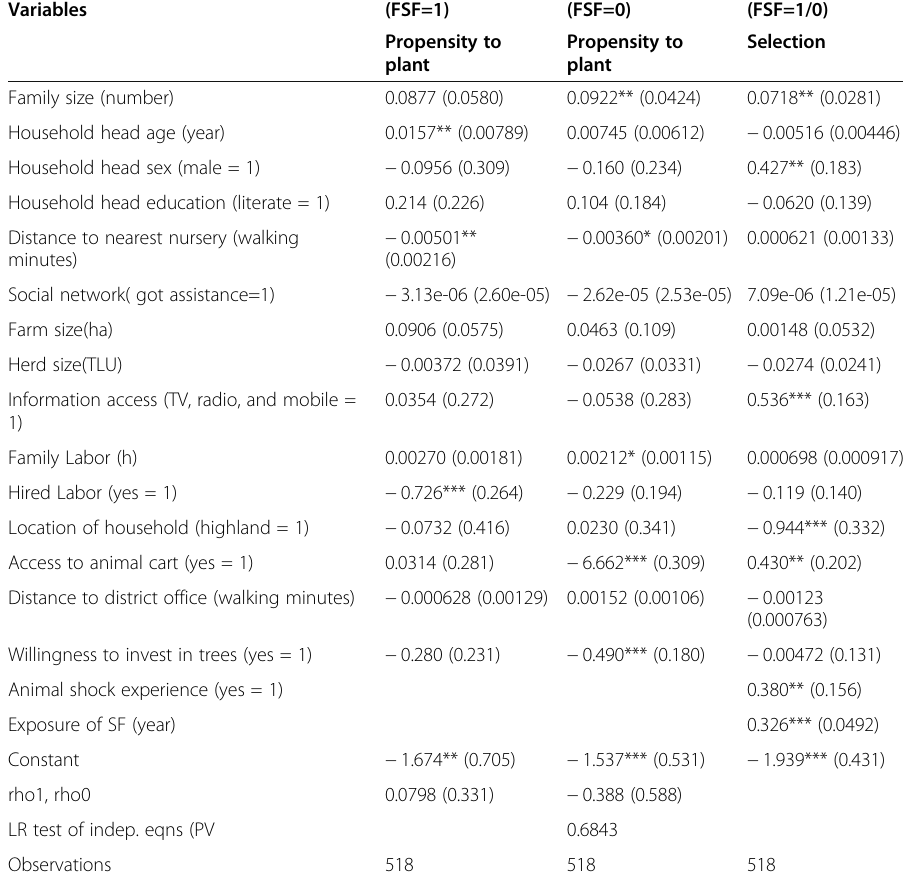
Table 5 Endogenous switching for FSF adoption and propensity to plant Variables (FSF=1) (FSF=0) (FSF=1/0)